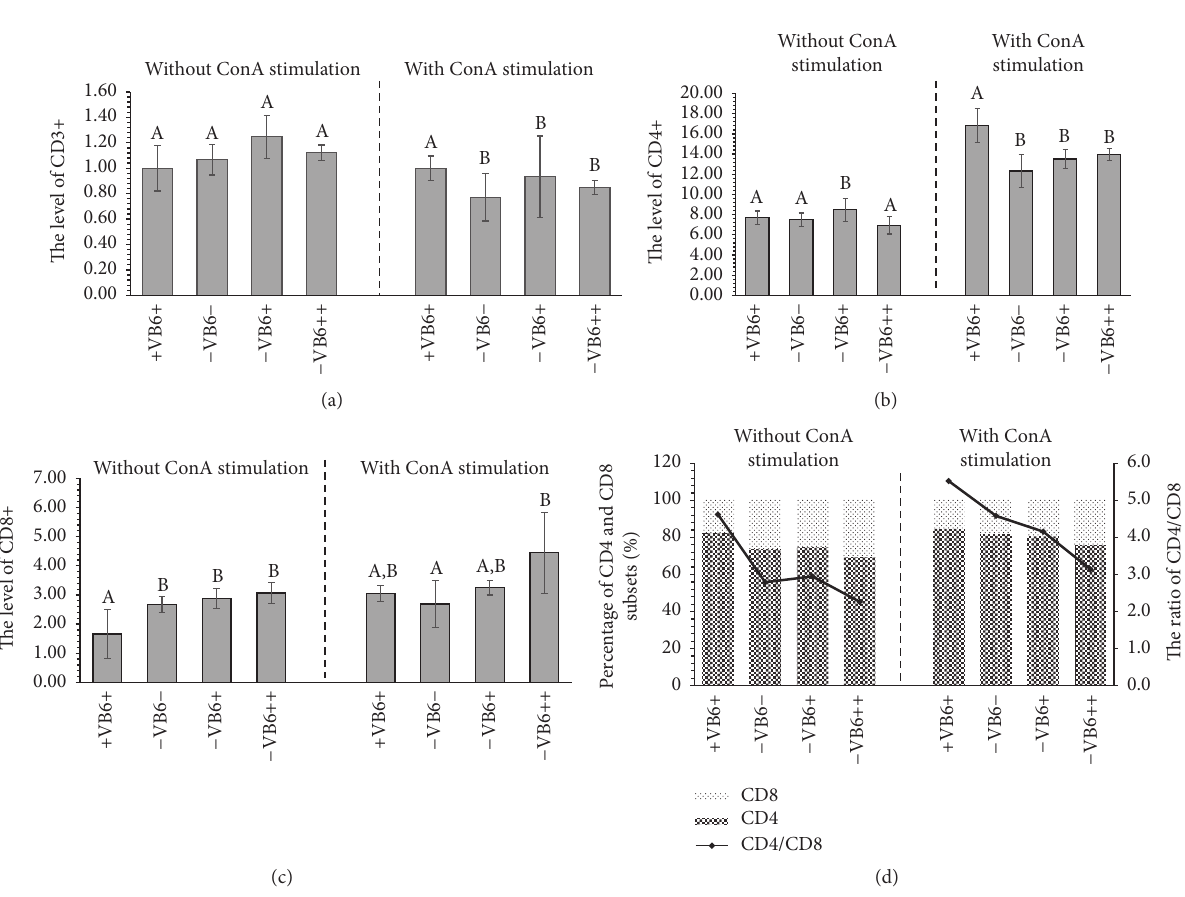
Figure 3: Level of T lymphocyte cell with or without ConA stimulation ((a), (b), and (c)) and differentiation of CD4+ and CD8+ subsets with or without ConA stimulation (d). Calculation was based on the percentage of concentration. Each group data represents mean values of seven replications with three independent experiments. Column marked with different alphabets denotes significant differences among the groups ( 𝑃 < 0.05